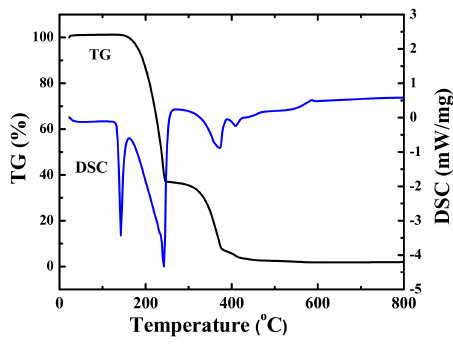
Figure 5. Thermogravimetry-Differential scanning calorimetry (TG-DSC) curves of the NH 4 H 2 PO 4 /RM